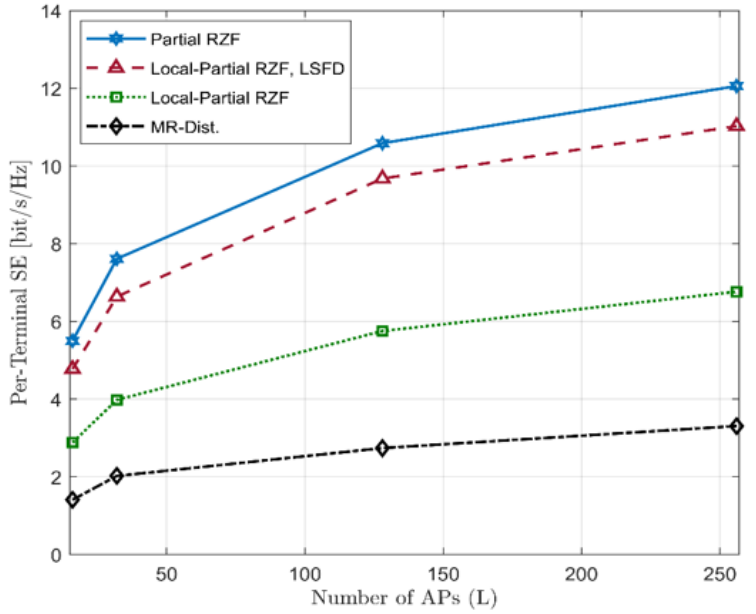
Figure 7. Average achievable SE as a function of L , with K = 8, and τ 0 = 8. Each AP is equipped by four antennas.